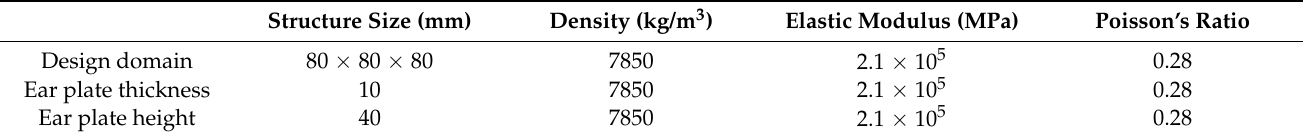
Figure 4. The node model of the finite element mesh division in ABAQUS (the red part is the load application area, and the green part is the design domain).